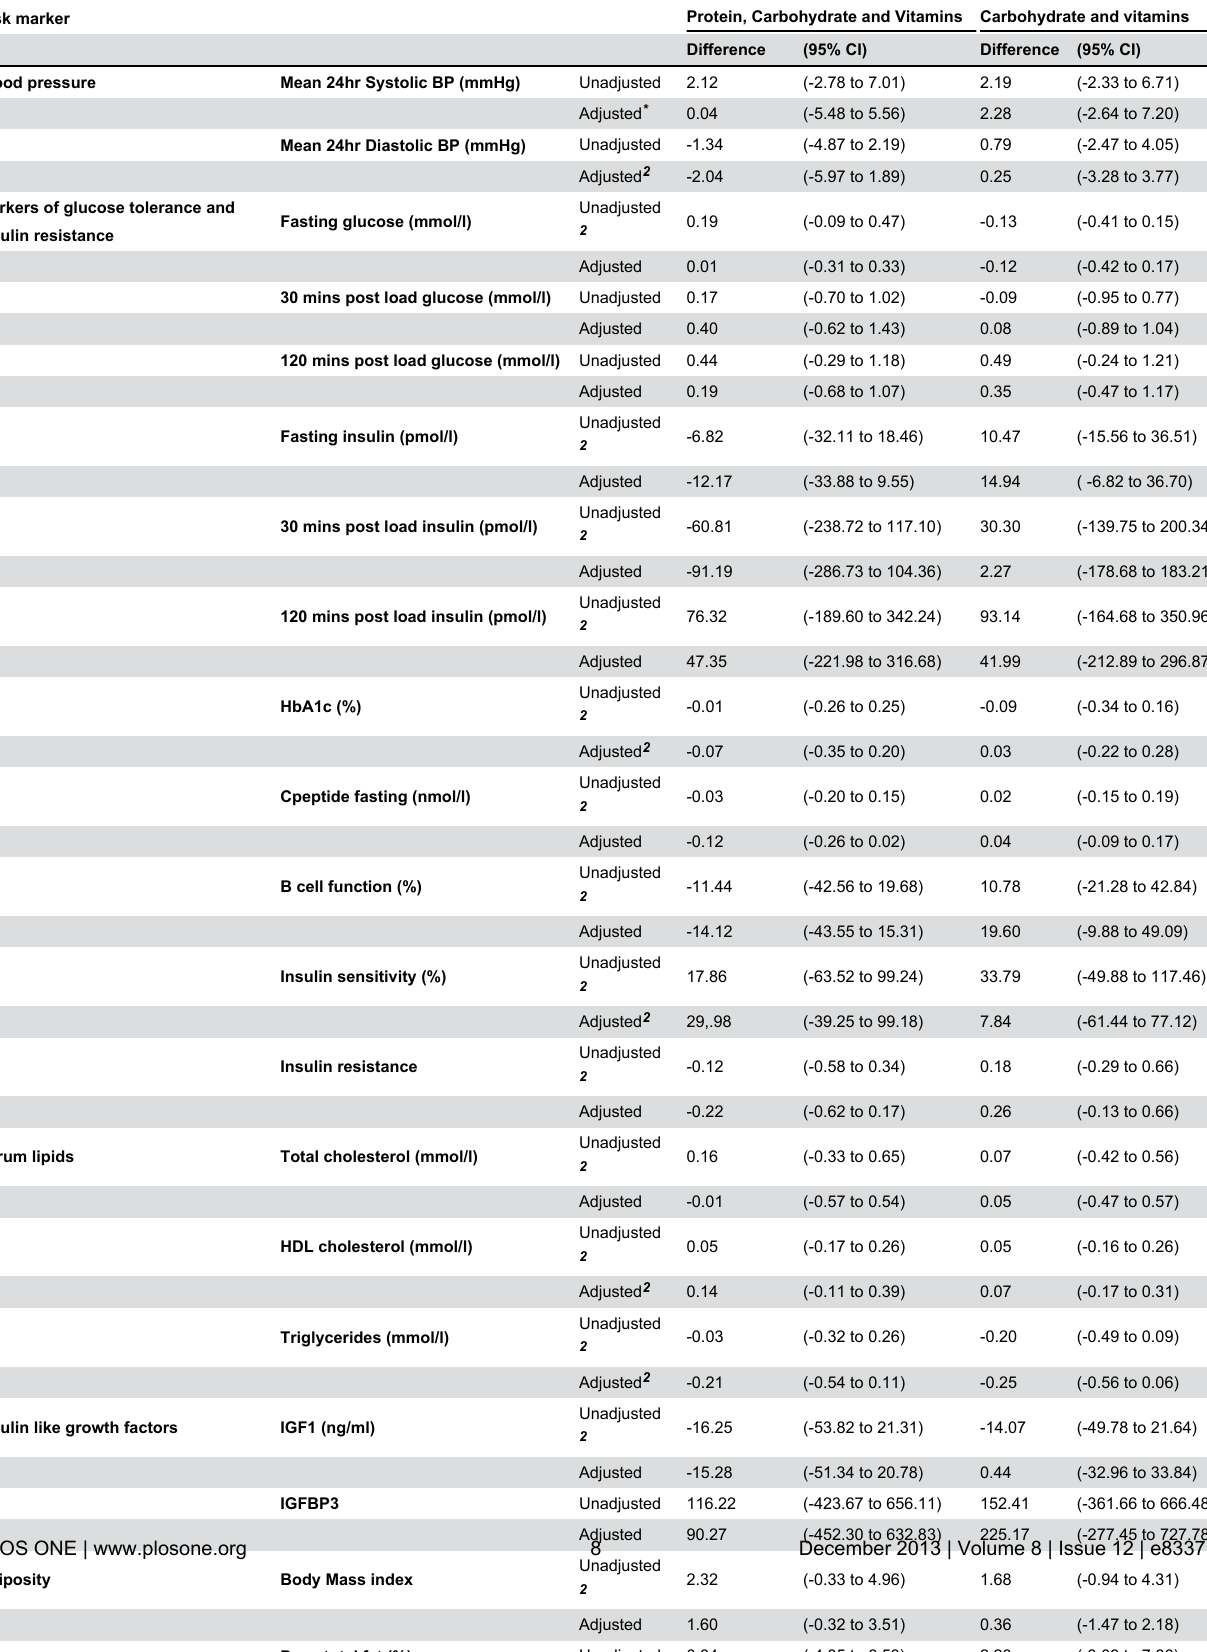
Table 4. Adult disease risk markers amongst offspring of mothers participating in the Sorrento studies of maternal nutritional supplementation who were assessed as adults: between group differences 1 - Trial I (supplementation in all mothers after 18